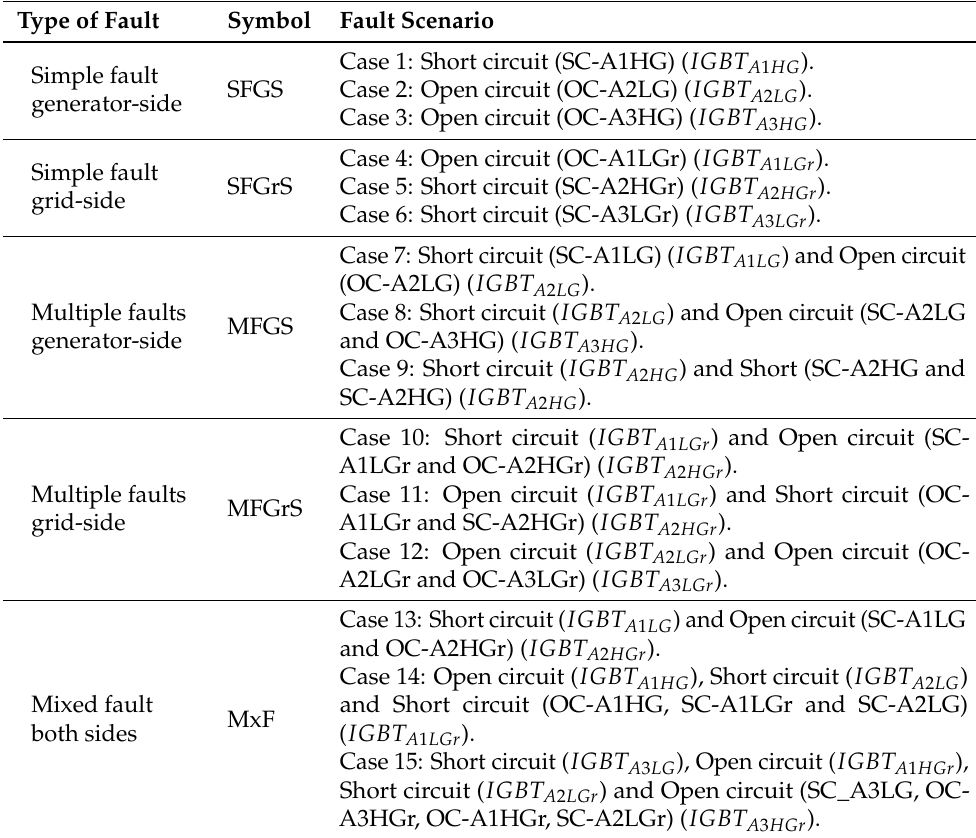
Figure 9. Illustration of failure mode distribution. Table 2. Construction of database for the fault diagnosis